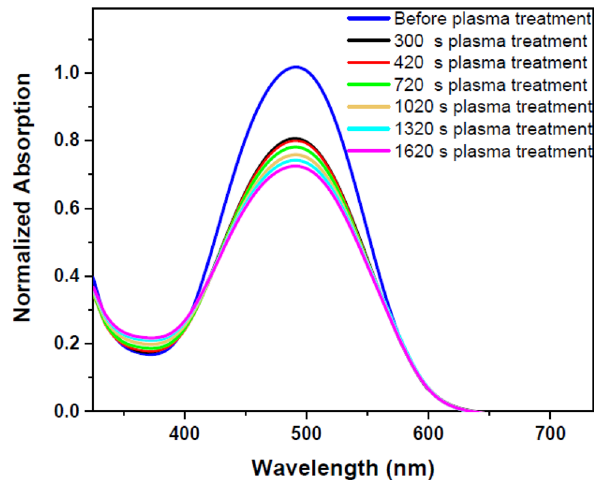
Figure 5. UV–Vis spectra of pristine and DR1 dye-doped PMMA polymer film with extra adsorbed surface dye through immersing in DR1 dye solution treated with argon plasma at various treatment